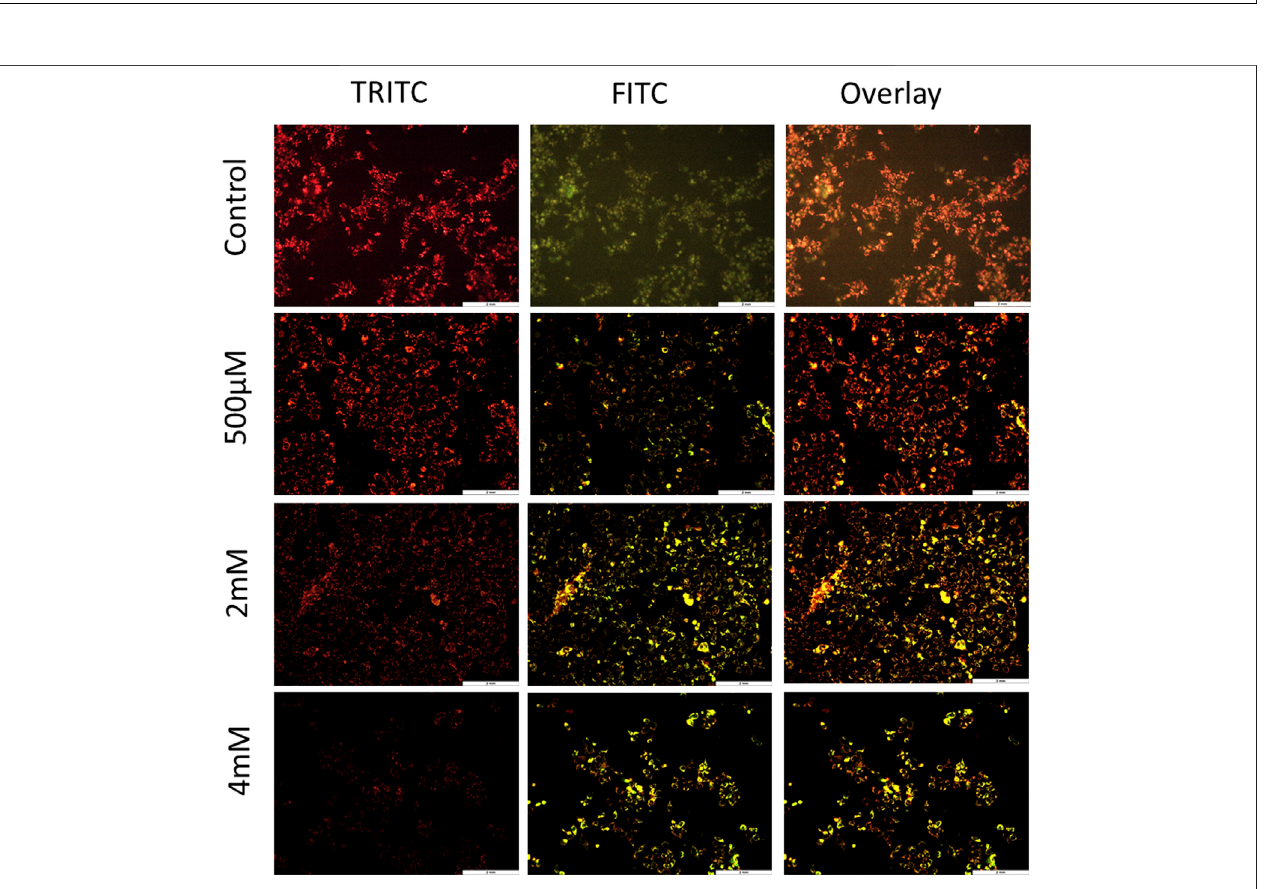
FIGURE 3 | HCT116 cells treated with GIV and analyzed for MMP loss using JC-1 staining. Cells exhibit more green fl uorescence with increasing GIV concentrations, indicating membrane potential loss. The cells were imaged at × 20 magni fi cation.